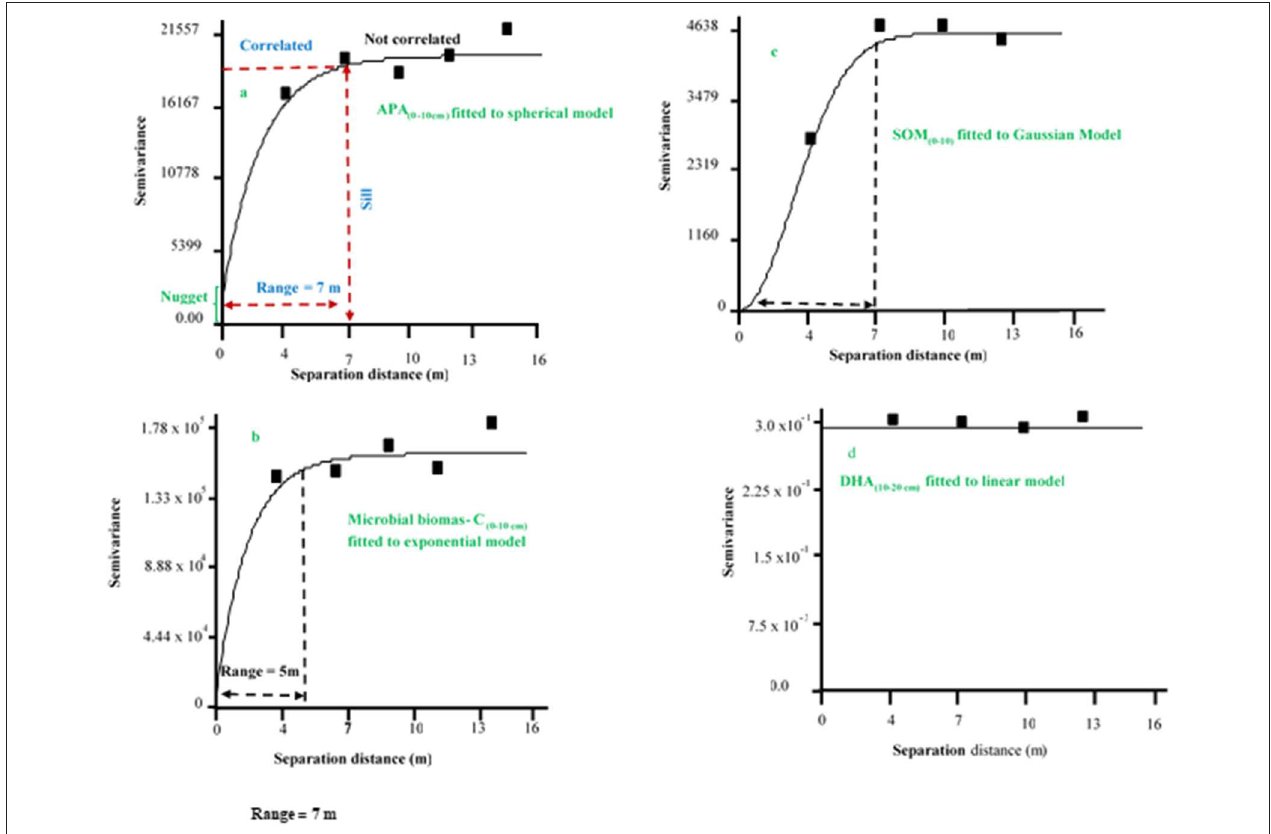
FIGURE 4 | Example of semivariogram of soil chemical and biochemical properties fitted to spherical, exponential, Gaussian, and linear models. APA, acid phosphatase activity; SOM, soil organic matter; DHA,